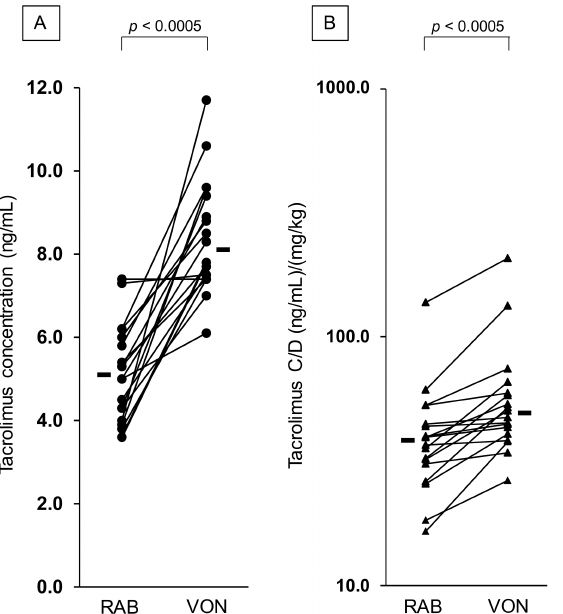
Figure 2. Effect of switching proton-pump inhibitor from rabeptazole to vonoprazan on the concen- tration ( A ) and C/D ratio ( B ) of tacrolimus. RAB, rabeprazole; VON, vonoprazan; C/D, concentra- tion/dose. Bars indicate median